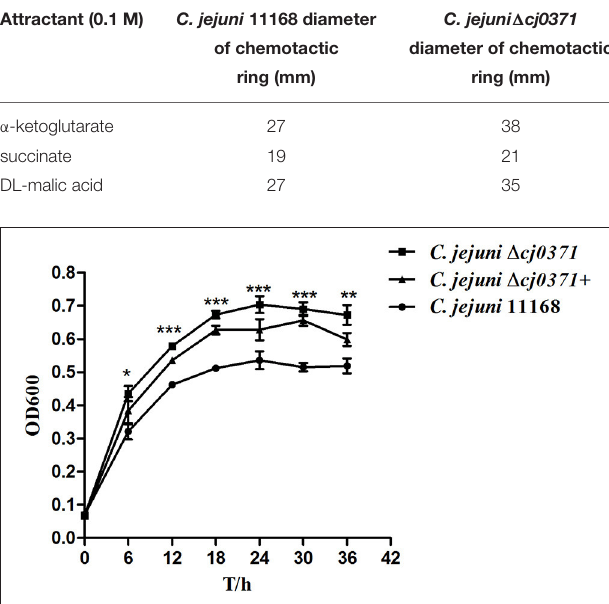
FIGURE 6 | Growth kinetics of C. jejuni 11168 and the cj0371 mutant in MH broth. The strains were cultured under microaerobic conditions at 42 ◦ C. At indicated time points, bacterial suspensions in anaerobic tubes were taken to measure OD 600 . The experiment was repeated three times, and the results of one representative experiment are shown. * P ≤ 0.01 ; ** P ≤ 0.05 ; *** P ≤ 0.001 .